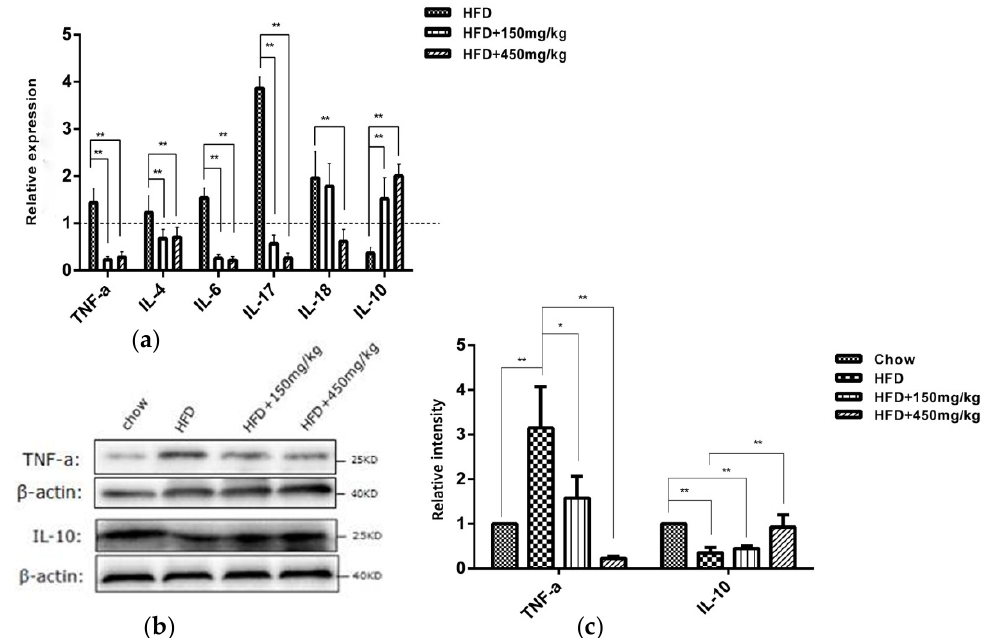
Figure 2. SIF affected mRNA expressions of cytokines in colon. ( a ) mRNA relative expressions (fold of chow) of TNF-a, IL-4, IL-6, IL-17, IL-18 and IL-10 in colon were assessed with qRT–PCR. ( b , c ) Western blots and quantification showed the protein levels of TNF-a and IL-10 in colon. Error bars indicate SD. * p < 0.05, ** p < 0.005. The dashed is the chow group.